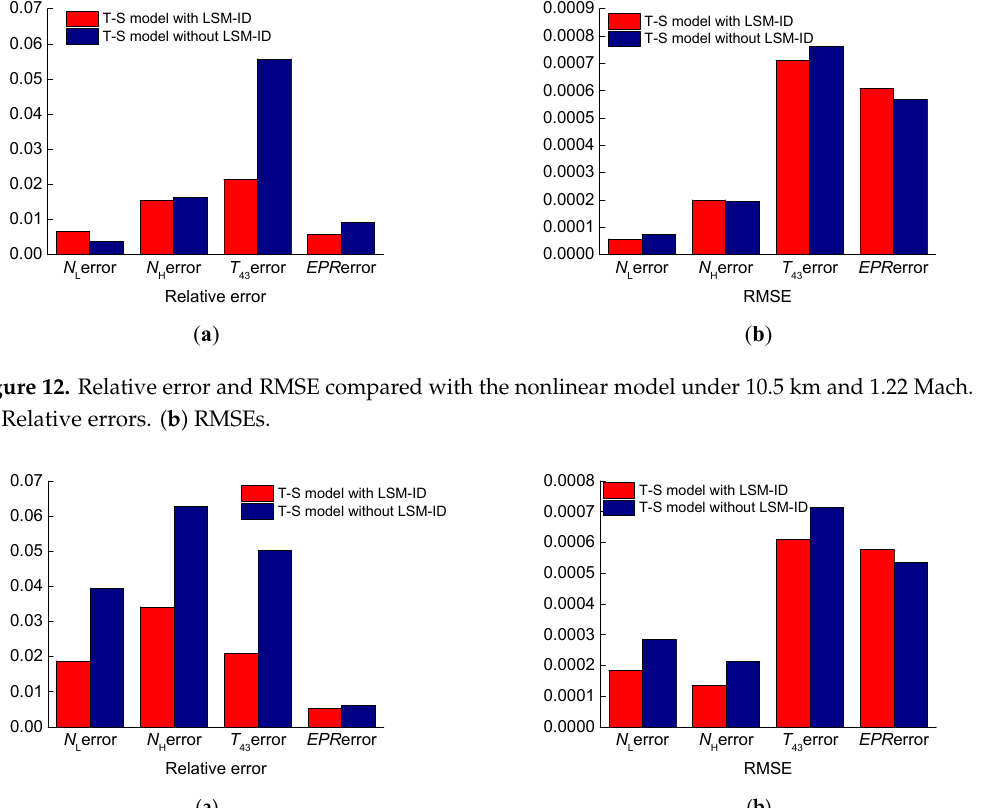
Figure 11. Response comparison under 7 km and 0.44 Mach. ( a ) N L response comparison. ( b ) N H responses. ( c ) T 43 responses. ( d ) EPR responses.